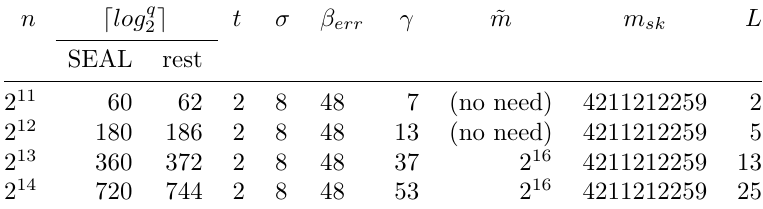
Table 4: Parameters for NFLlib-FV, GPU-FV RNS , G-CPU-FV K80 and SEAL-FV RNS